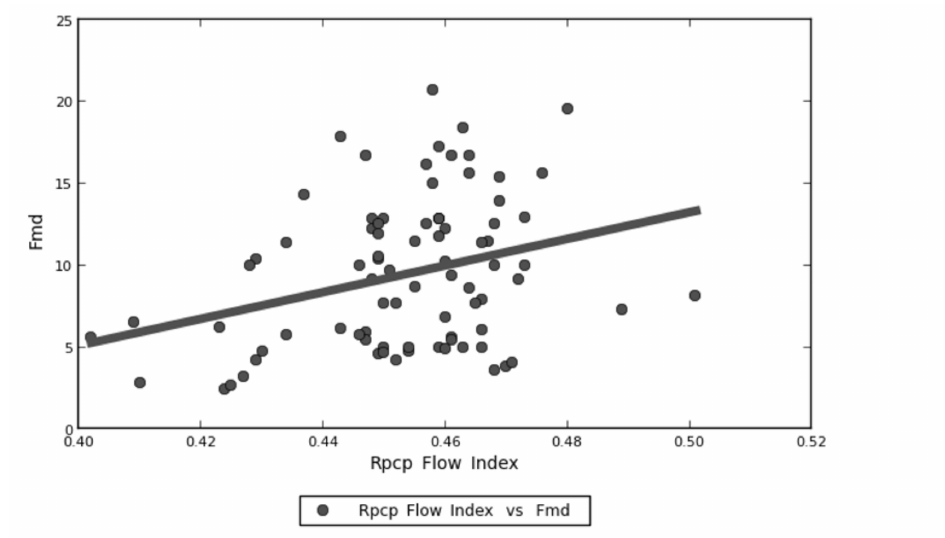
Figure 6. Distribution of radial peripapillary capillary plexus flow index (RPCP-FI) and flow- mediated dilation (FMD) values. Spearman’s linear correlation between RPCP-FI and FMD values in early post-COVID-19